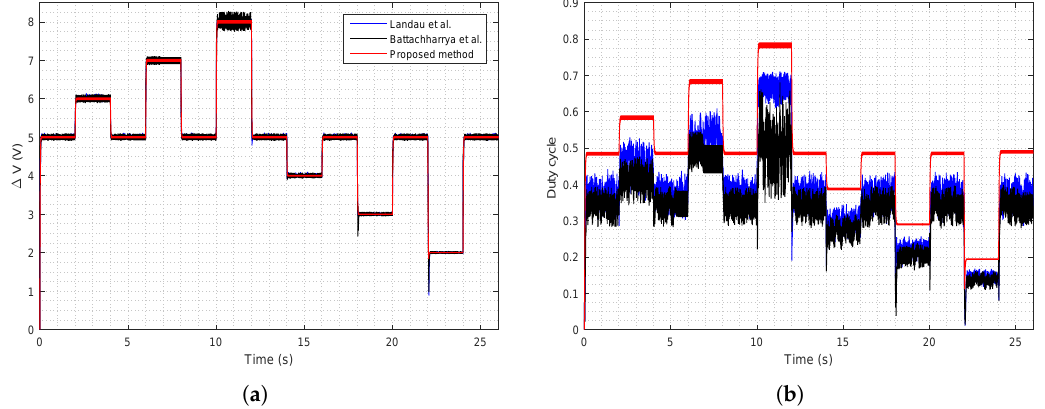
Figure 8. Simulation results of the voltage setpoint variation. ( a ) Voltage variation; ( b ) Duty cycle.